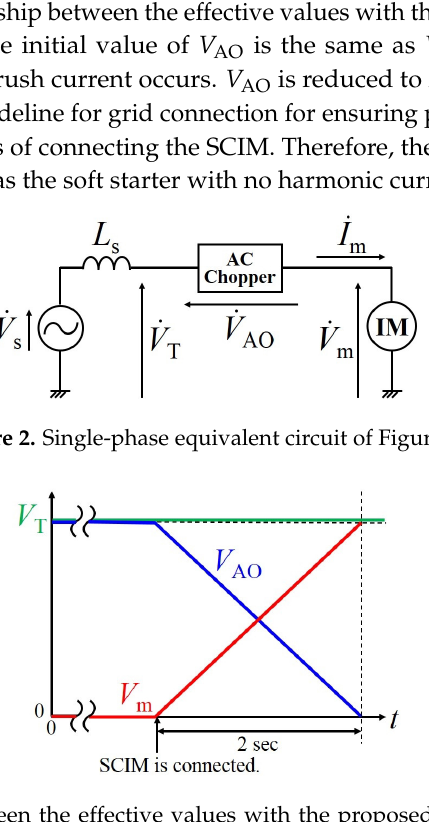
Figure 3. Relationship between the effective values with the proposed AC chopper-based inrush current